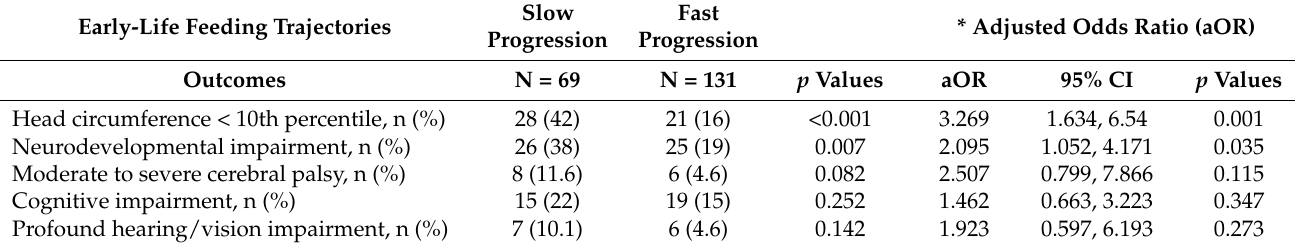
Table 2. Differences in proportions of microcephaly and neurodevelopmental impairment outcomes at corrected age 24 months between the fast progression and slow progression feeding pattern groups in early